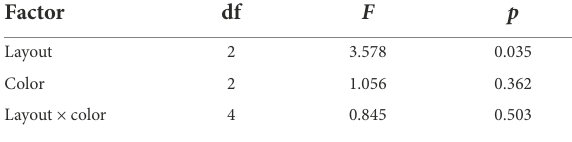
TABLE 6 Results of repeated measures ANOVA on correct rate.